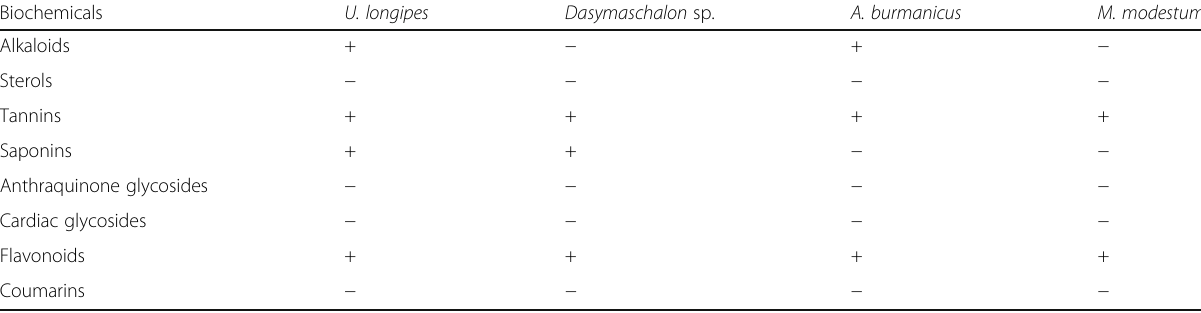
Table 4 Phytochemical analysis of Crude Methanolic Extract